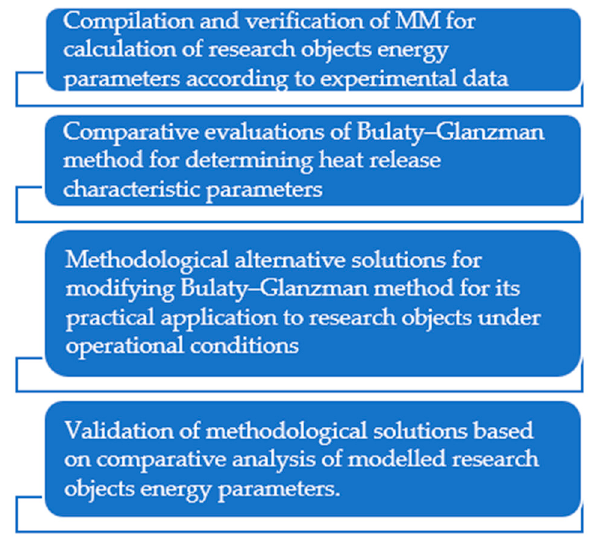
Figure 1. The structural components of the methodology.